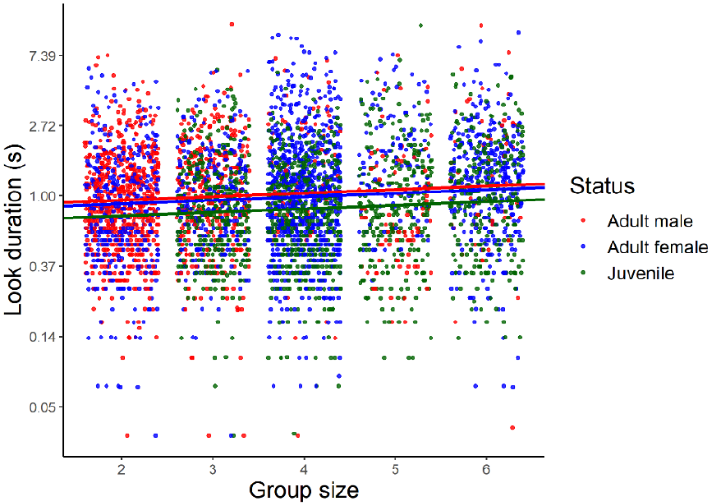
Figure 3. Distribution of look duration (s) during sentinel bouts as a function of group size in three different classes of Florida scrub-jays (juveniles, adult males, and adult females). The duration of looks is in logarithmic scale. Regression lines were obtained from a generalized linear mixed model implemented using a Bayesian framework with log-normal error distribution.